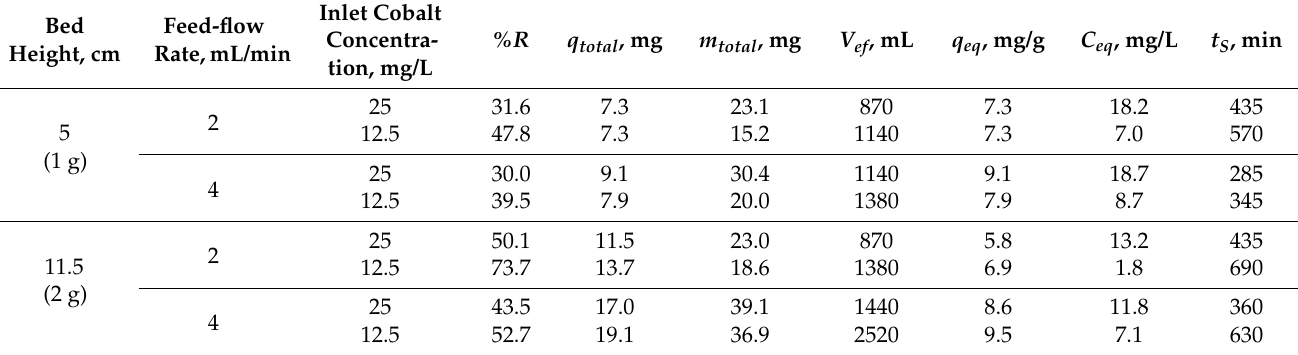
Table 2. Main parameters of the breakthrough curves for the different operating